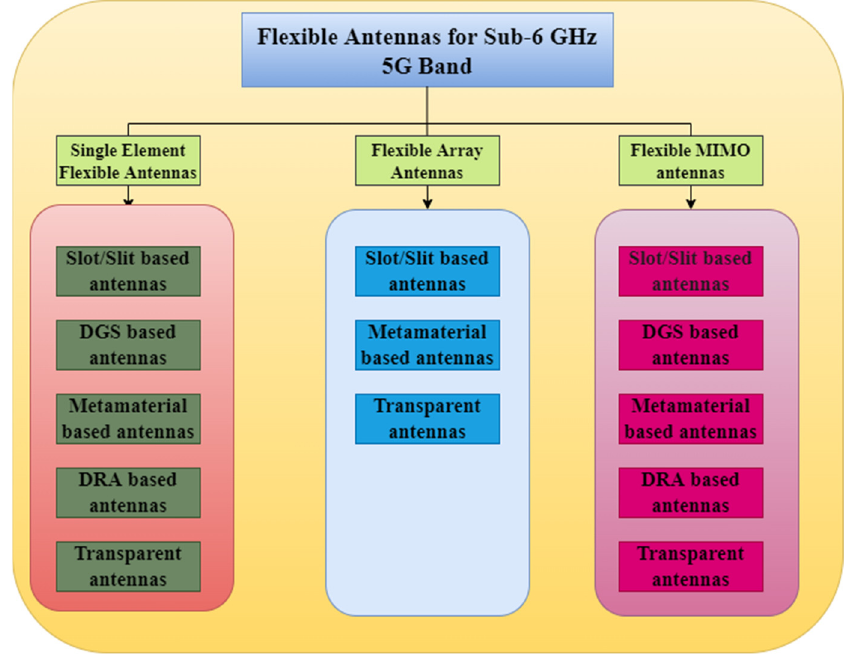
Figure 6. Overview of flexible antennas for the sub-6 GHz 5G band